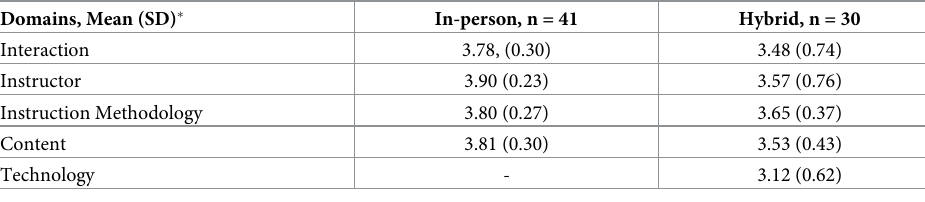
Table 7. In-person and Hybrid mean and standard deviation total